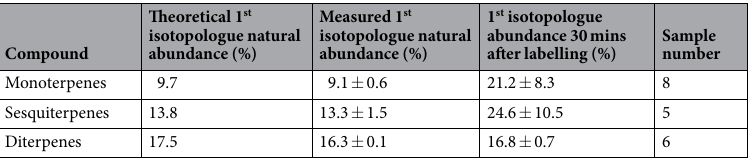
Table 1. Change in the proportion (%) of the heavy isotopologue ( 13 C) molecules with respect to the parent monoterpenes, sesquiterpenes and diterpenes for the labelling experiments. Ten different (only detectable isotopic signals for each isoprenoid are show H . halimifolium individuals were used for this